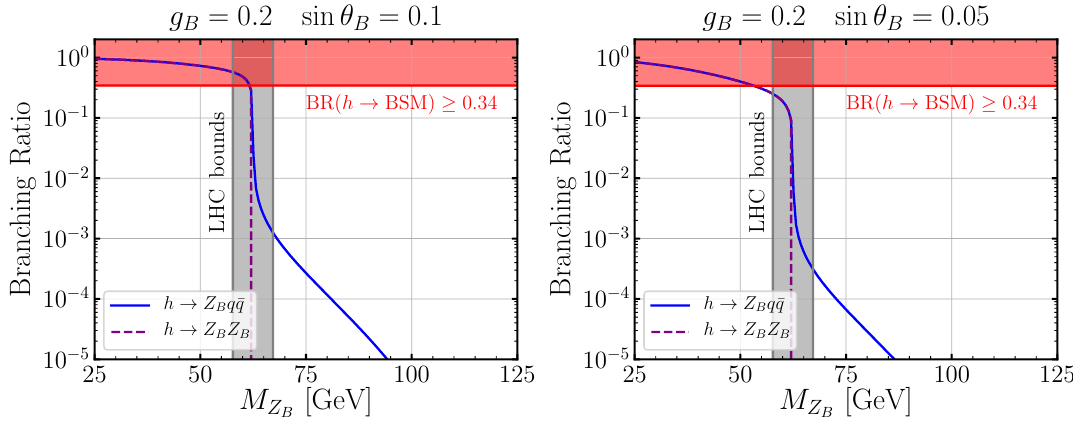
Figure 5 . Branching ratios for the channels h panel corresponds to g B = 0 : 2 and sin (cid:18) B = 0 : 1 (sin (cid:18) B = 0 : 05). The region shaded in red shows the exclusion bounds from the constraint on the SM-like Higgs branching ratio BR( h 0.34. The region shaded in gray corresponds to the exclusion bounds from direct searches for the Z B boson at the